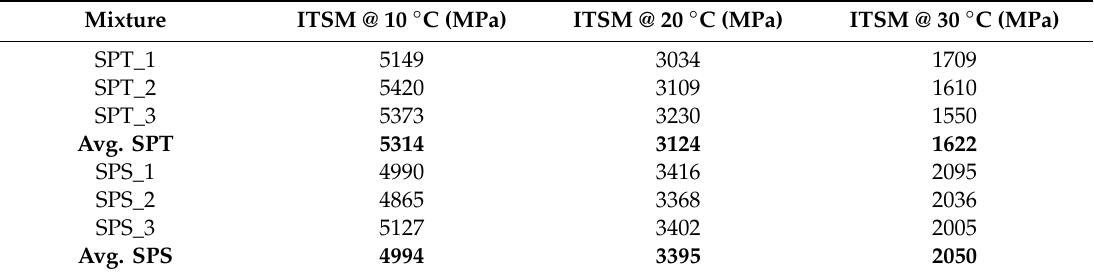
Figure 5. Average Indirect Tensile Stiffness Modulus (ITSM) results at 10, 20 and 30 °C. Table 5. ITSM test results.